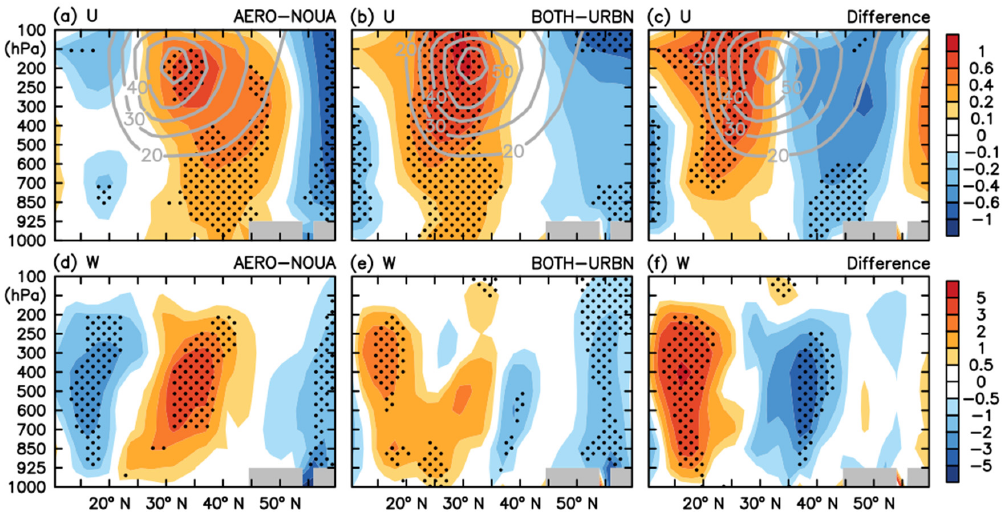
Figure 6. ( a – c ) Vertical distributions of NDJ-mean AA-induced changes in zonal wind (U; color shading, in m/s) averaged over 105°–140° E from ( a ) AERO − NOUA; ( b ) BOTH − URBN; and ( c ) their difference (i.e., ( b ) minus ( a )). ( d – f ) Same as ( a – c ), but for changes in vertical velocity ( ω ; color shading, in hPa/day). The gray contours in ( a – c ) indicate the climatology of U ( ≥ 20 m/s, with an interval of 10 m/s) in BOTH, donating the East Asian westerly jet-stream.